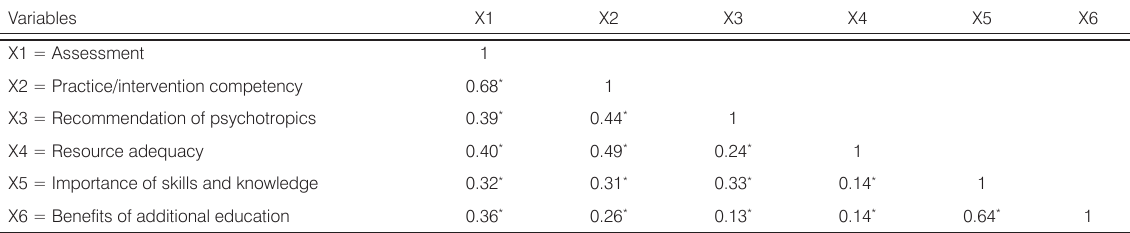
Table 3. Correlation among